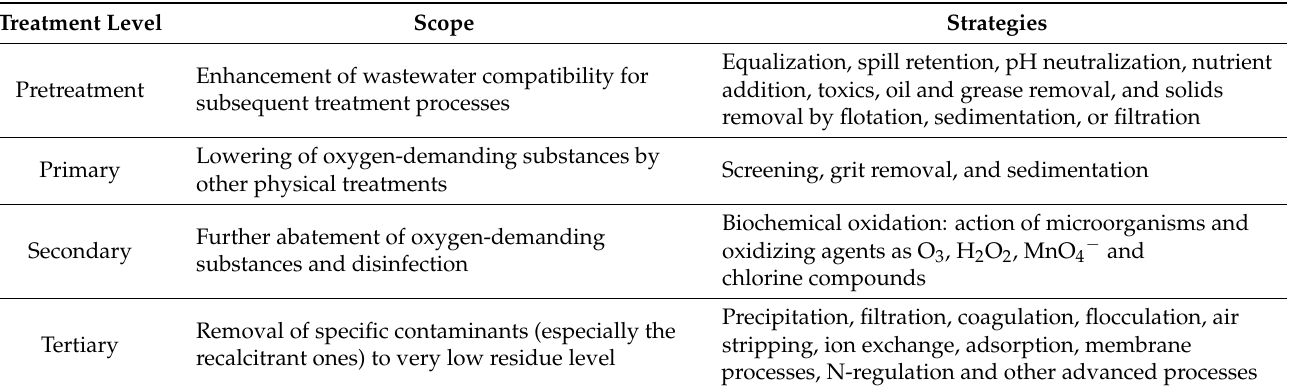
Table 1. Wastewater treatment levels